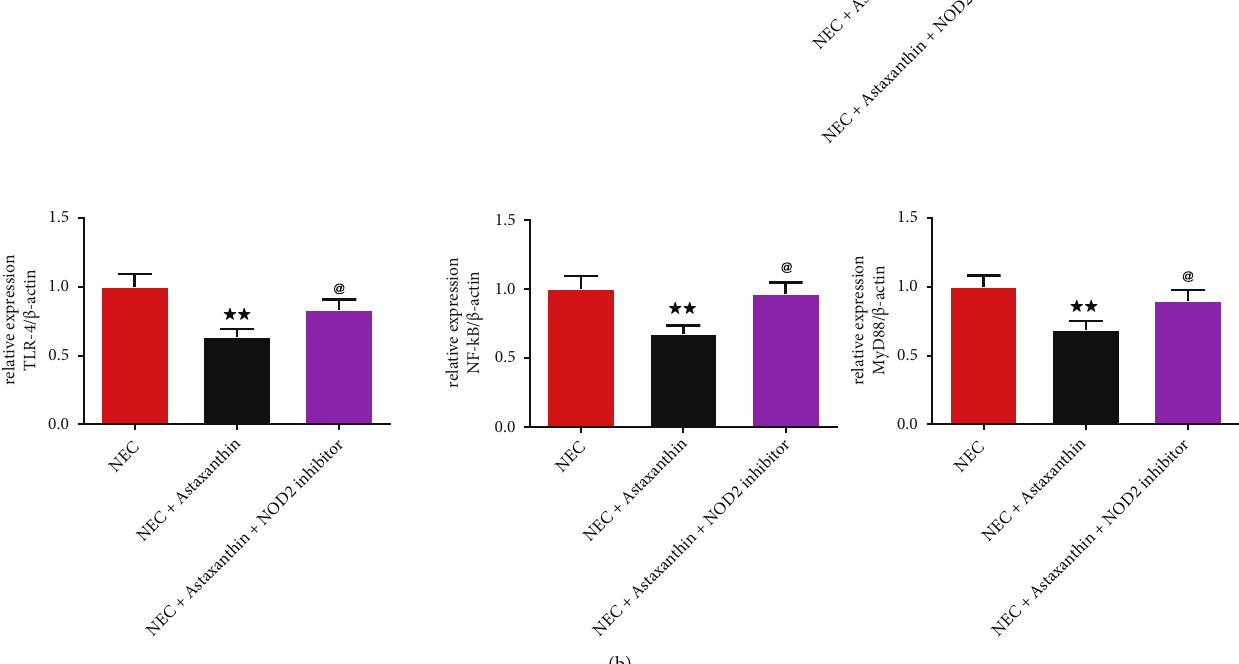
Figure 6: Astaxanthin exerts protective e ff ect by activating NOD2 and inhibiting TLR4 signaling pathway on intestinal tissues in NEC rats. (a and b) Western blot was used to test the expressions of NOD2, TLR4, NF-kB, and MyD88 of intestinal tissues in rats, n = 3 in each group; ★★ P < 0 : 01 vs. NEC group, @ P < 0 : 05 , @@ P < 0 : 01 vs. NEC +Astaxanthin